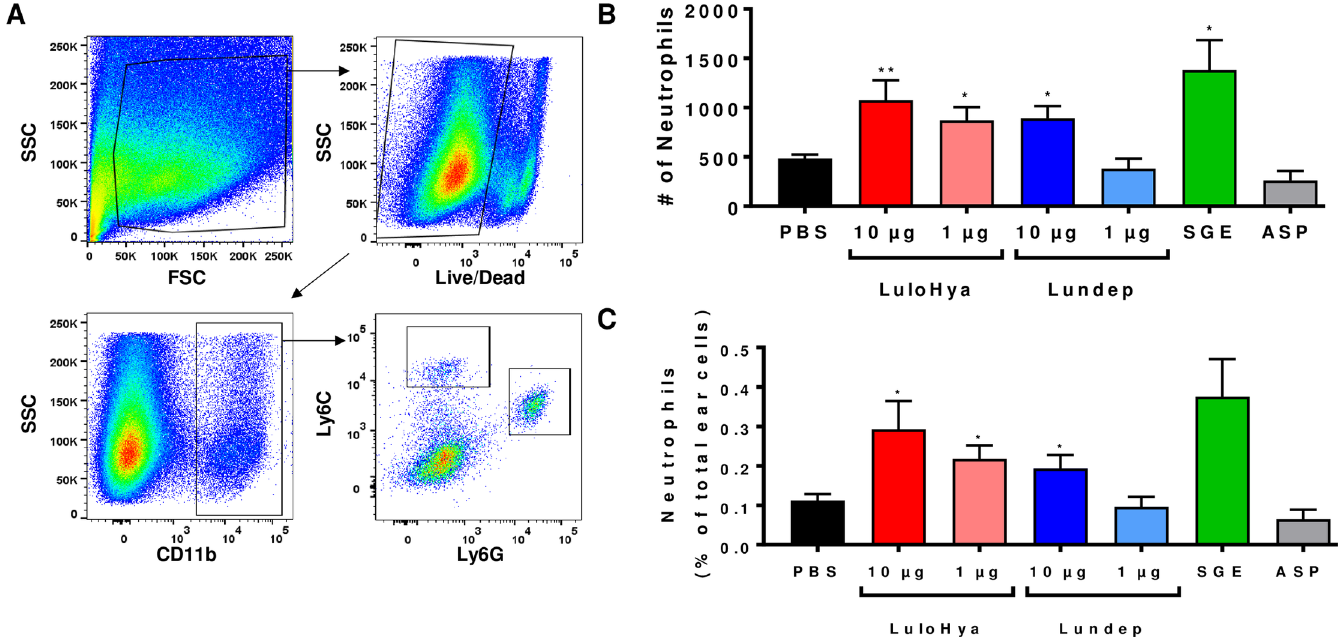
Fig 7. In vivo recruitment of polymorphonuclear leukocytes by LuloHya, Lundep or SGE in mice. Recruitment of neutrophils to the inoculation site was determined by flow cytometry analysis. ( A ) Gating strategy analysis based on the CD11b expression to identify neutrophils (Ly6G + Ly6C int ) and inflammatory monocytes (Ly6G - Ly6C hi ). Mice (C57BL/6) were intradermally inoculated with LuloHya (10 μ g and 1 μ g), Lundep (10 μ g and 1 μ g), Lu . longipalpis SGE (equivalent to 2 SG pairs) and PBS alone as a negative control. Ears injected with 1 μ g of non-related salivary protein from Ae . aegypti (ASP) were also included. After 2 h, the ears were collected and processed for flow cytometry analysis. (B) Total count of neutrophils per ear. ( C ) Frequency of neutrophils in mouse ears. Results (of at least 2 independent experiments) are shown as mean +/- SEM. Comparisons with PBS group were done by Mann-Whitney U test ( (cid:3)(cid:3) : p < 0.01; (cid:3) : p < 0.05).